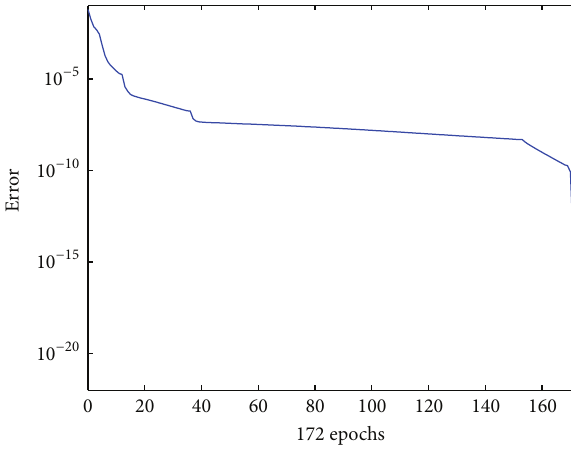
Figure 13: Training of epochs by ANN.